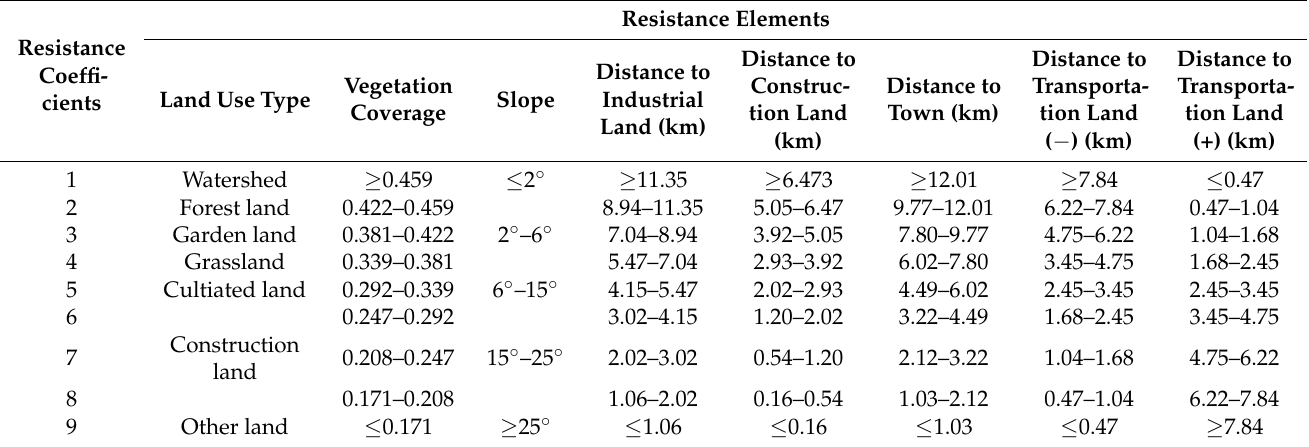
Table 2. The resistance coefficients of the resistance